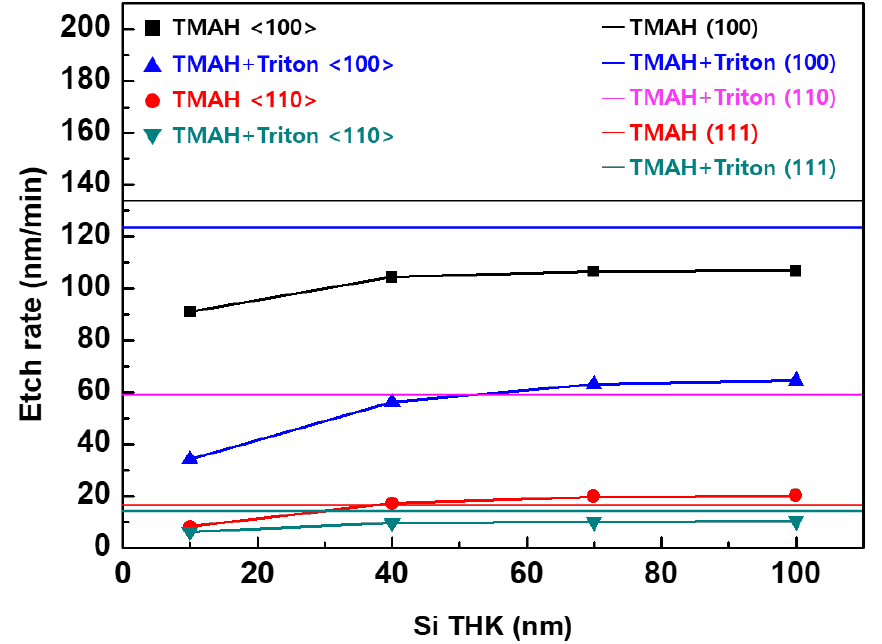
Figure 11. Si etching rates in the multi-layered wafers (symbols) and in the oxide wafers (lines).